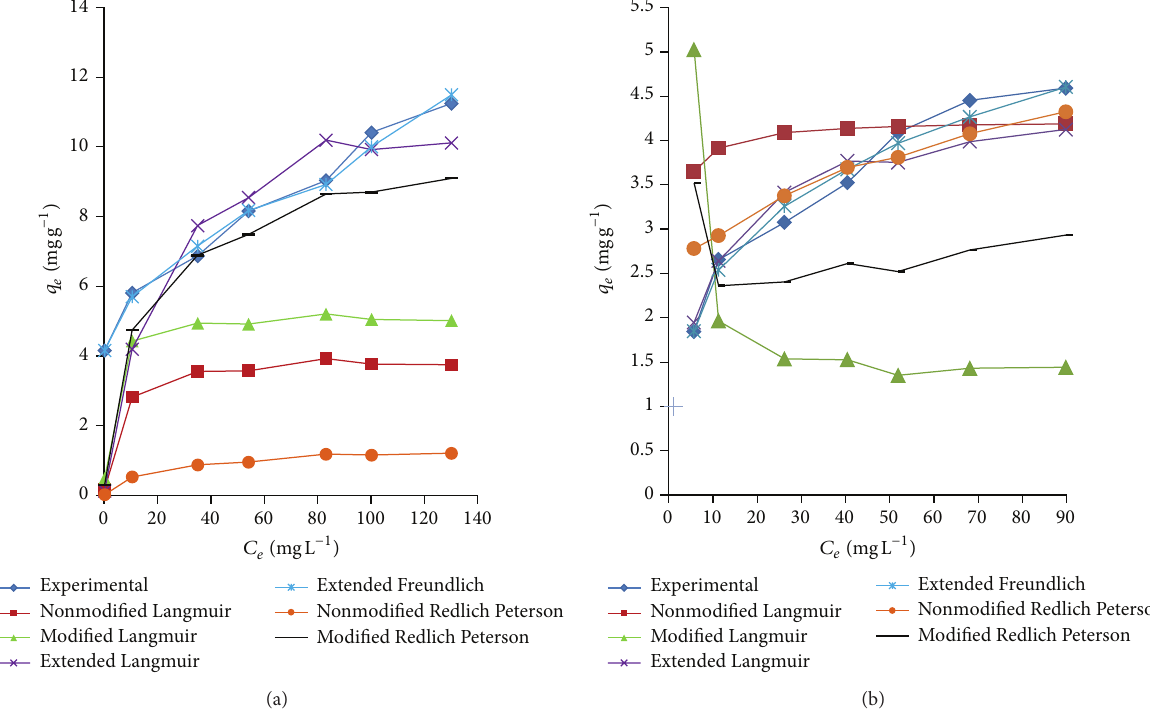
Figure 8: (a) Comparison of multicomponent isotherm for Cr(VI). (b) Comparison of multicomponent isotherm for phenol.